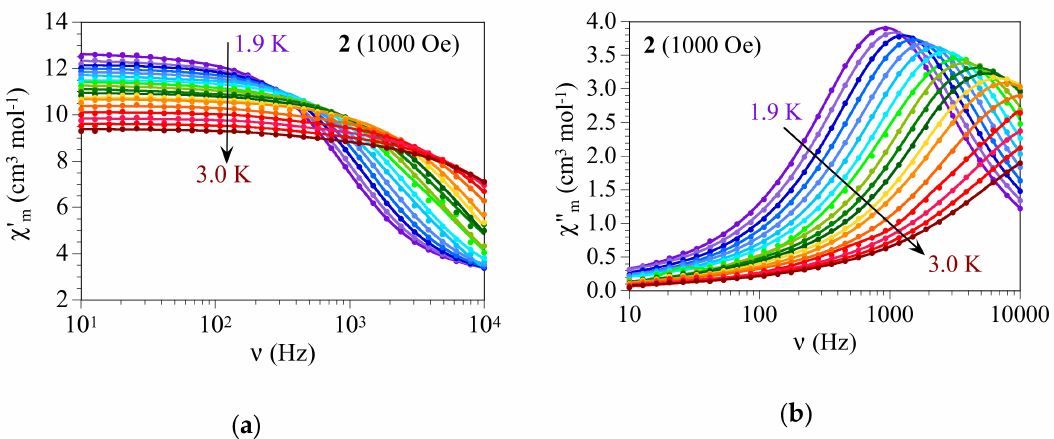
Figure 9. ( a ) Frequency dependence of χ (cid:48) m for compound 2 with H dc = 1000 Oe in the temperature range 1.9–3.0 K; ( b ) Frequency dependence of χ (cid:48)(cid:48) m for compound 2 with H dc = 1000 Oe in the temperature range 1.9–3.0 K. Solid lines are the best fit to the Debye model.